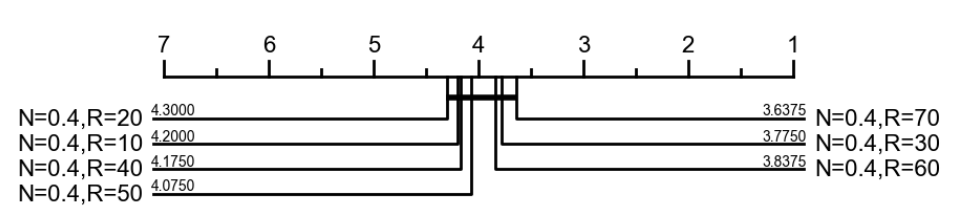
Figure 7. Mean rank of different numbers of realizations applied on CEEMD-MultiRocket with a fixed noise